Question: What type of chart is this?
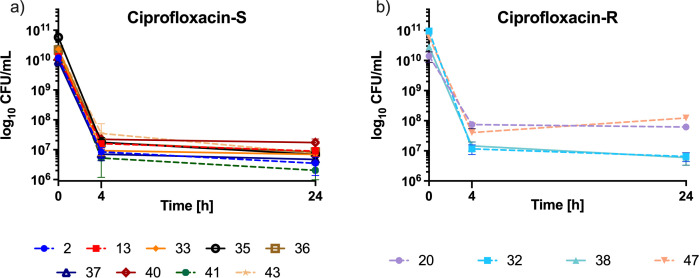
Answer: bar